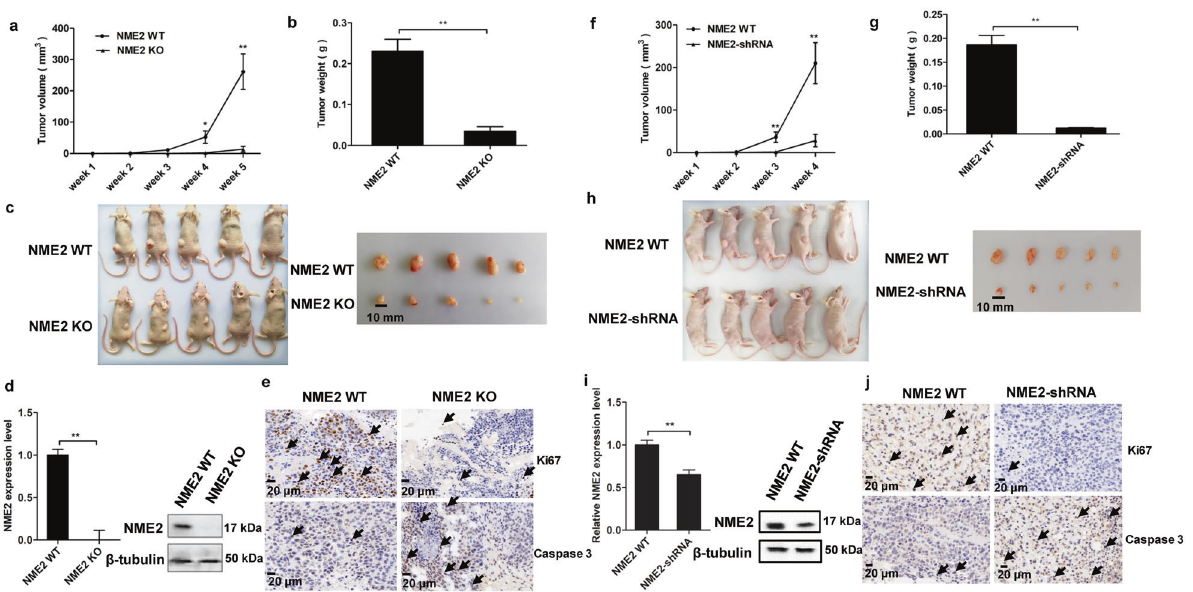
Fig. 4 Effects of NME2 on gastric cancer stem-like cells from solid tumors of patients. a The expression level of NME2 protein in NME2- silenced or -rescued in gastric cancer stem-like cells sorted from solid tumors of two gastric cancer patients. The protein was examined by western blot. β -Tubulin was used as a control. b Impact of NME2 knockdown and rescue on the cell number of gastric cancer stem-like cells. The gastric cancer stem-like cells sorted from solid tumors were transfected with NME2-shRNA to silence the NME2 expression. To rescue the NME2 expression, the NME2-silenced cells were transfected with the plasmid expressing NME2. At different days after transfection, the cell number was counted ( ** p < 0.01). c In fl uence of NME2 knockdown and rescue on the cell viability of gastric cancer stem-like cells. The NME2- silenced cells were transfected with the plasmid expressing NME2, and the cell viability was examined at different times after transfection ( ** p < 0.01). d Role of NME2 in cell cycle of gastric cancer stem-like cells sorted from solid tumors of two gastric cancer patients. The NME2-knock- down cells were transfected with the plasmid expressing NME2. At 48 h after transfection, the cells were subjected to the examination of cell cycle ( ** p < 0.01). e Impact of NME2 knockdown and rescue on the caspase 3/7 activity of gastric cancer stem-like cells. The NME2-knocked- down cells were transfected with the plasmid expressing NME2. At 48 h after transfection, the caspase 3/7 activity of cells was examined ( ** p < 0.01). f Flow cytometry detection of the impact of NME2 knockdown and rescue on apoptosis of gastric cancer stem-like cells sorted from solid tumors. The cells transfected with the plasmid expressing NME2 were cultured for 48 h, followed by the examination of apoptosis using Annexin V ( ** p < 0.01). g Tumorsphere formation assay of the NME2-silenced or -rescued gastric cancer stem-like cells sorted from solid tumors. At day 8 after the inoculation of a single cell, the percentage of tumorsphere formation was calculated ( ** p < 0.01). h In fl uence of NME2 knockdown and rescue on the expressions of stemness genes in gastric cancer stem-like cells from solid tumors. At 48 h after NME2 rescue, the expressions of stemness genes were examined with quantitative real-time PCR or western blot ( ** p <